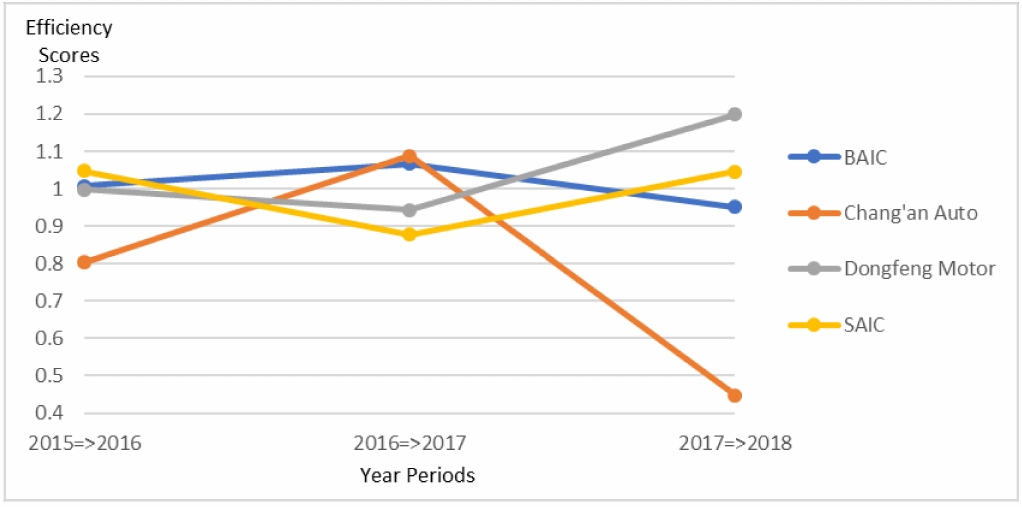
Figure 4. Technical-e ffi ciency changes of Chinese